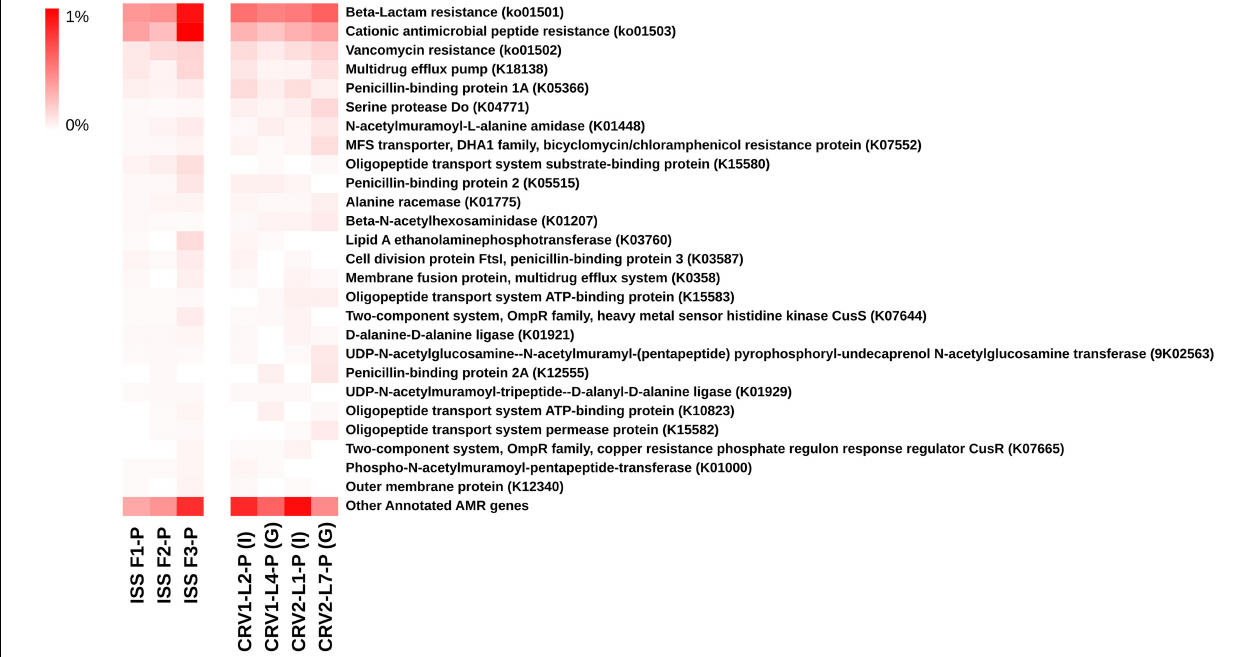
FIGURE 4 | Distribution of the antibiotic resistance genes detected in metagenomes generated from PMA treated samples collected from the internal (I) and ground support equipment (G) surfaces of CRV1 and CRV2 and three sampling events on the